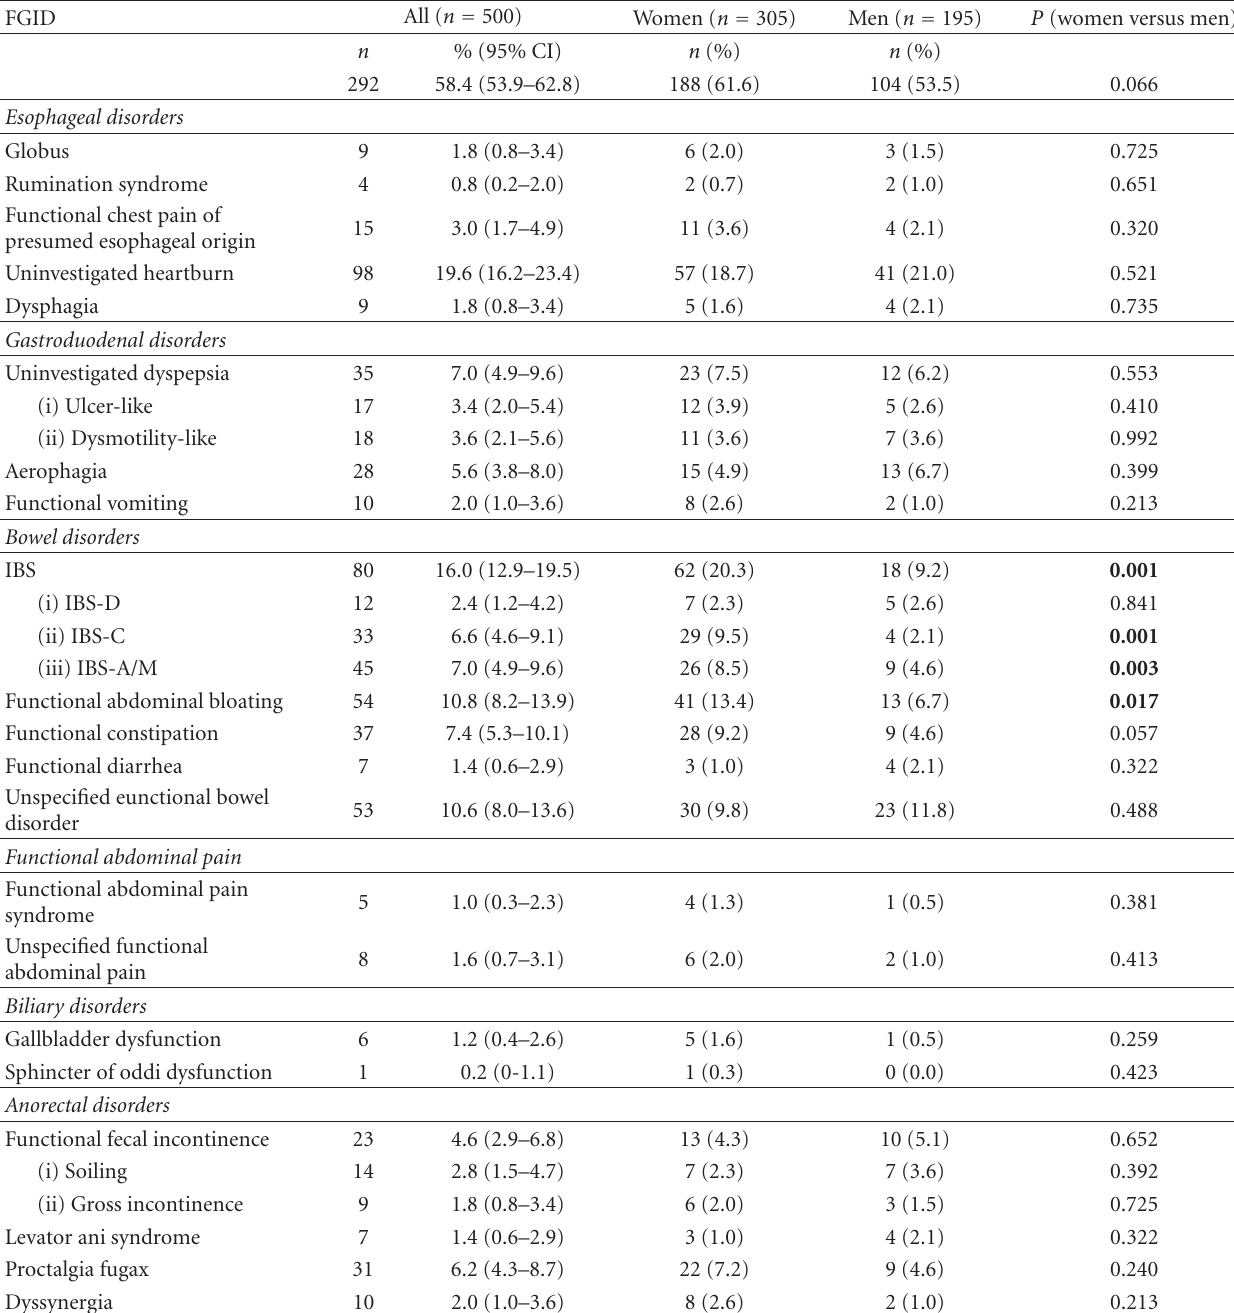
Table 2: Prevalence of functional gastrointestinal